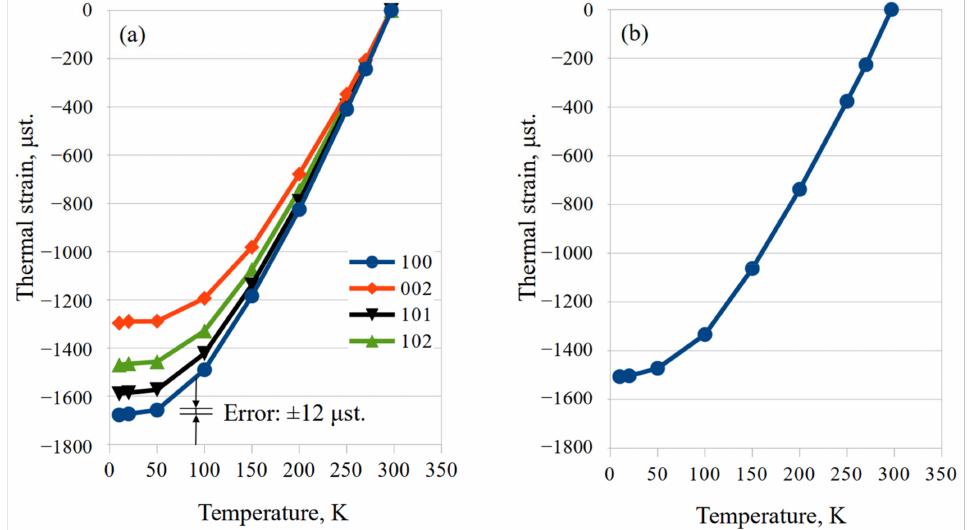
Figure 8. Alterations of thermal strains determined from the results of the diffraction peak measure- ments of ( a ) the titanium matrix and ( b ) the tungsten fibers in the W/Ti